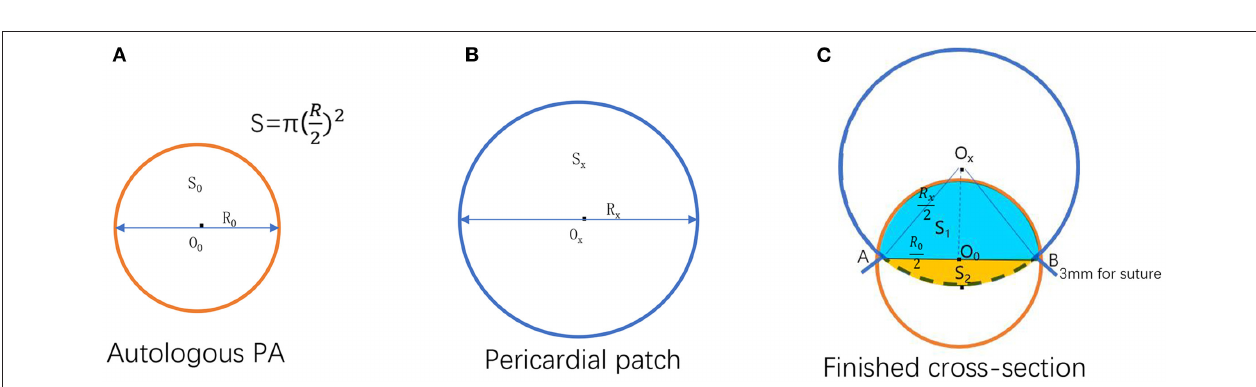
FIGURE 2 | Illustration for formula deduction. (A) Autologous pulmonary artery cross-section. (B) A fictitious circle formed by the pericardial patch before the procedure. (C) The cross-section of the reconstructed pulmonary valve annulus that combined the pericardial patch and the autologous pulmonary artery after the operation [O 0 , O x : The center of the circle formed by autologous pulmonary valve annulus and pericardial patch, respectively; The area and the diameter of the autologous pulmonary valve annulus, respectively; the area and the diameter of the circle formed by uncorrected pericardial patch, respectively; The area and the diameter of the circle formed by the corrected pericardial patch, respectively. The overlapped part of the circle formed by the autologous pulmonary artery and pericardial patch after reconstruction; (A,B) Suture point of the autologous pulmonary artery and pericardial patch].